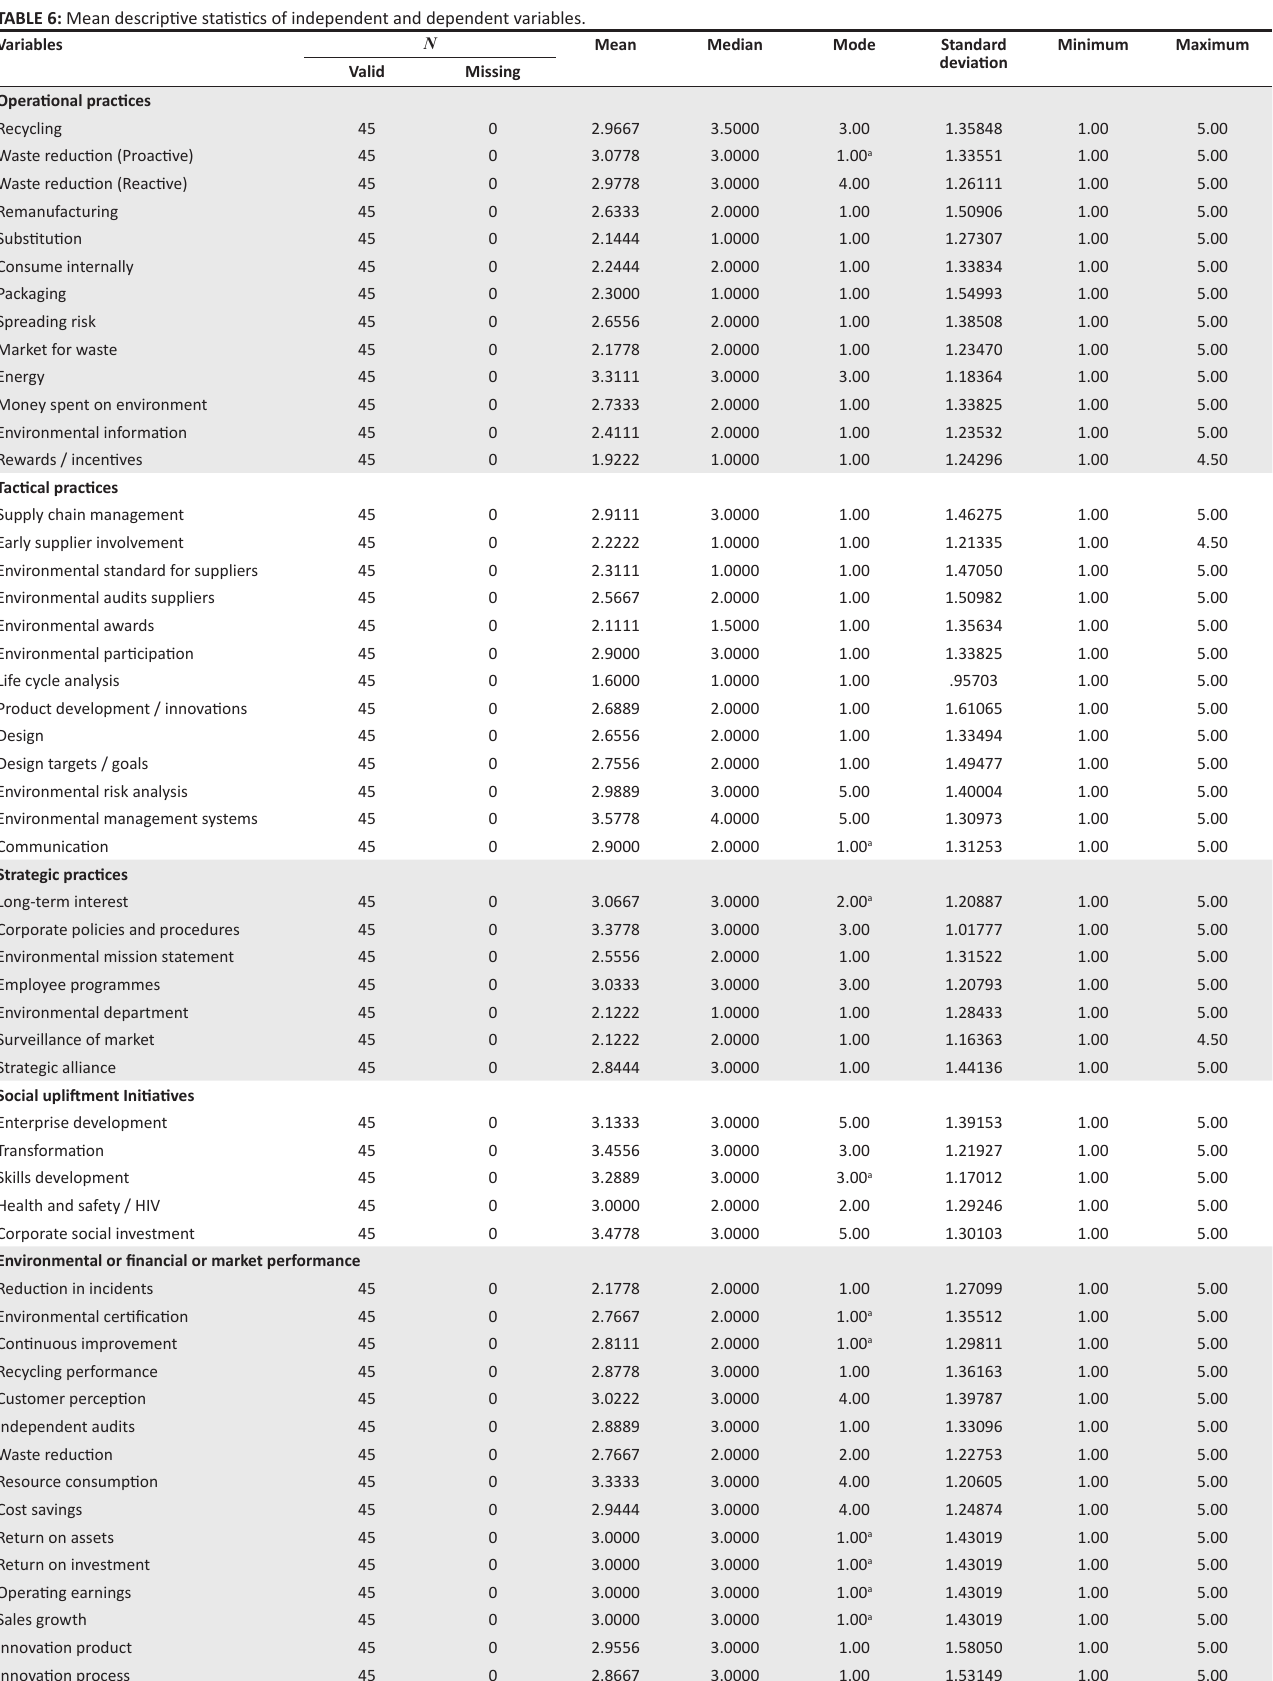
TABLE 6: Mean descriptive statistics of independent and dependent variables.